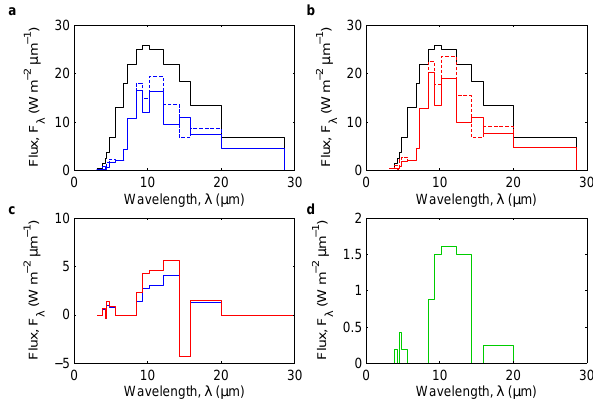
Fig. 8. Comparison of spectrally resolved longwave forcings for in- crease from standard to 50000ppmv CO 2 in real cloud (RC, blue) and cloud-free (CF, red) models. Green is for differences in cases (CF − RC) and black is for fluxes common between cases. (a) RC: F ↑ surf in black, F ↑ TOA dashed blue for standard CO 2 and solid LW LW blue for elevated CO 2 ; (b) CF: F ↑ surf in black, F ↑ TOA dashed red LW LW for standard CO 2 and solid red for elevated CO 2 ; (c) greenhouse forcing from increased CO 2 : G = G( High CO 2 ) − G( Std CO 2 ) − F ↑ TOA where G = F ↑ surf ; (d) difference in greenhouse forcing: LW LW D G = G ( CF ) − G (